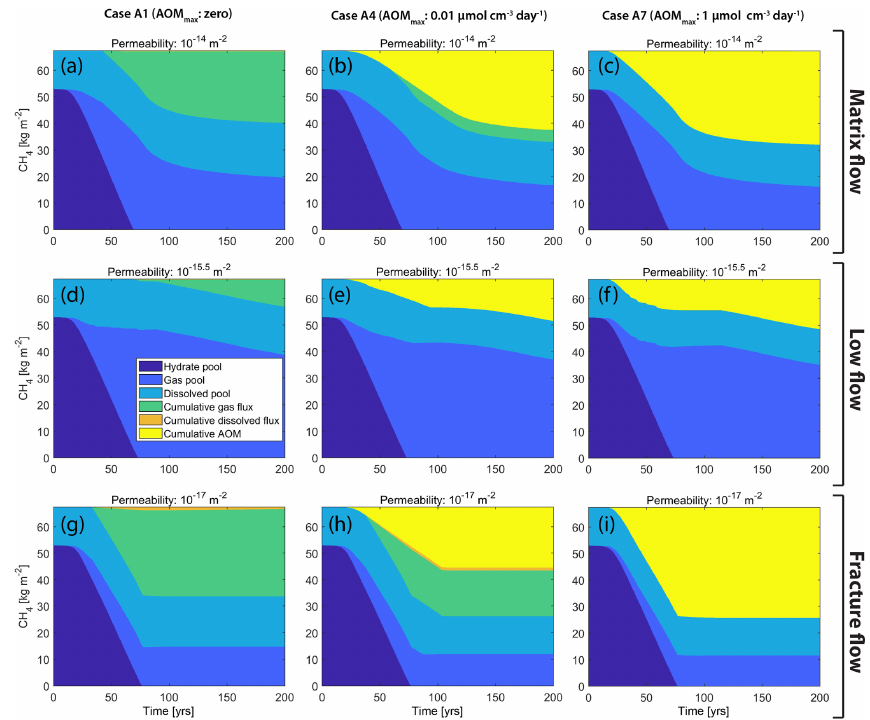
Figure 5. CH 4 mass budget over time showing the five components of Fig. 1 with the dissolved and gaseous fluxes separated. Displayed are three examples (high, mid- and low permeability; rows) for three different cases (Cases A1, A4 and A7; columns). Note that differ- ence in cumulative CH 4 gas escape (green area) between high and low permeability is significantly larger in Case A4 (b, h) compared to Case A1 (a, g)